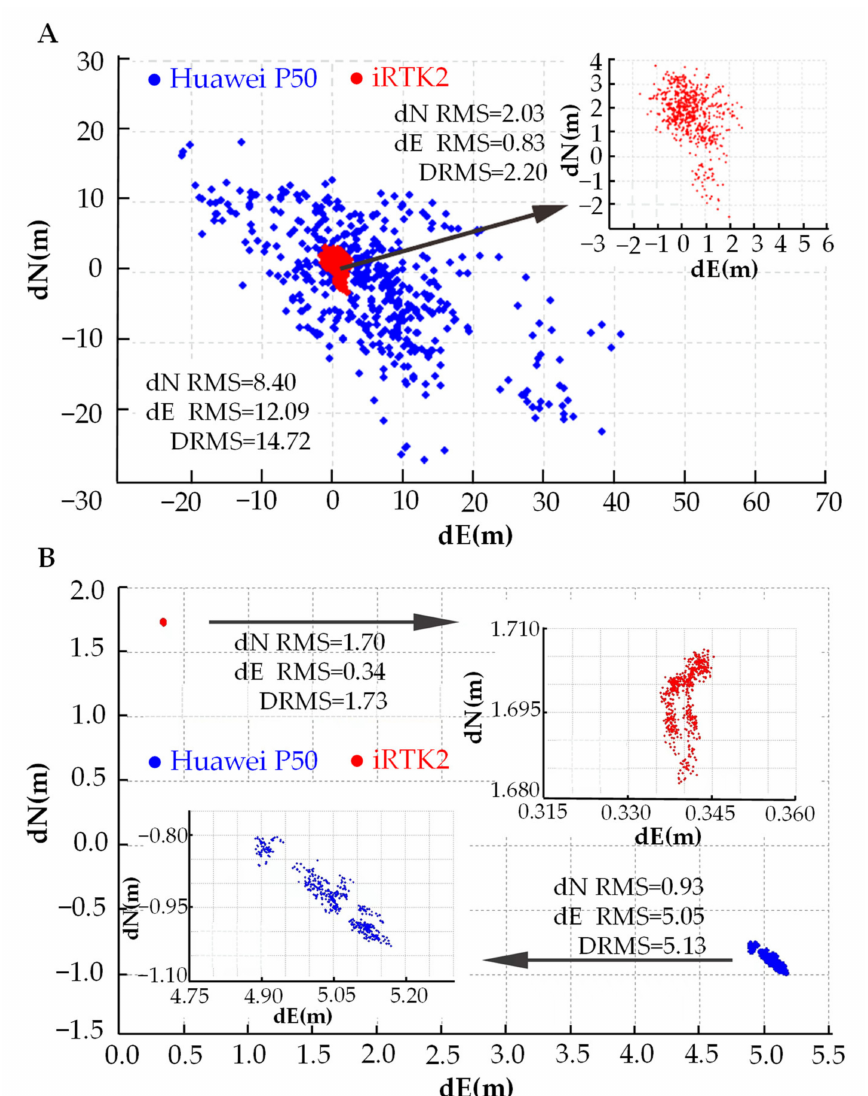
Figure 13. Comparison of positioning accuracy between dual-frequency smartphone P50 and survey- grade receiver iRTK2 in SPP model ( A ); comparison of positioning accuracy between dual-frequency smartphone P50 and survey-grade receiver iRTK2 in PPP model ( B